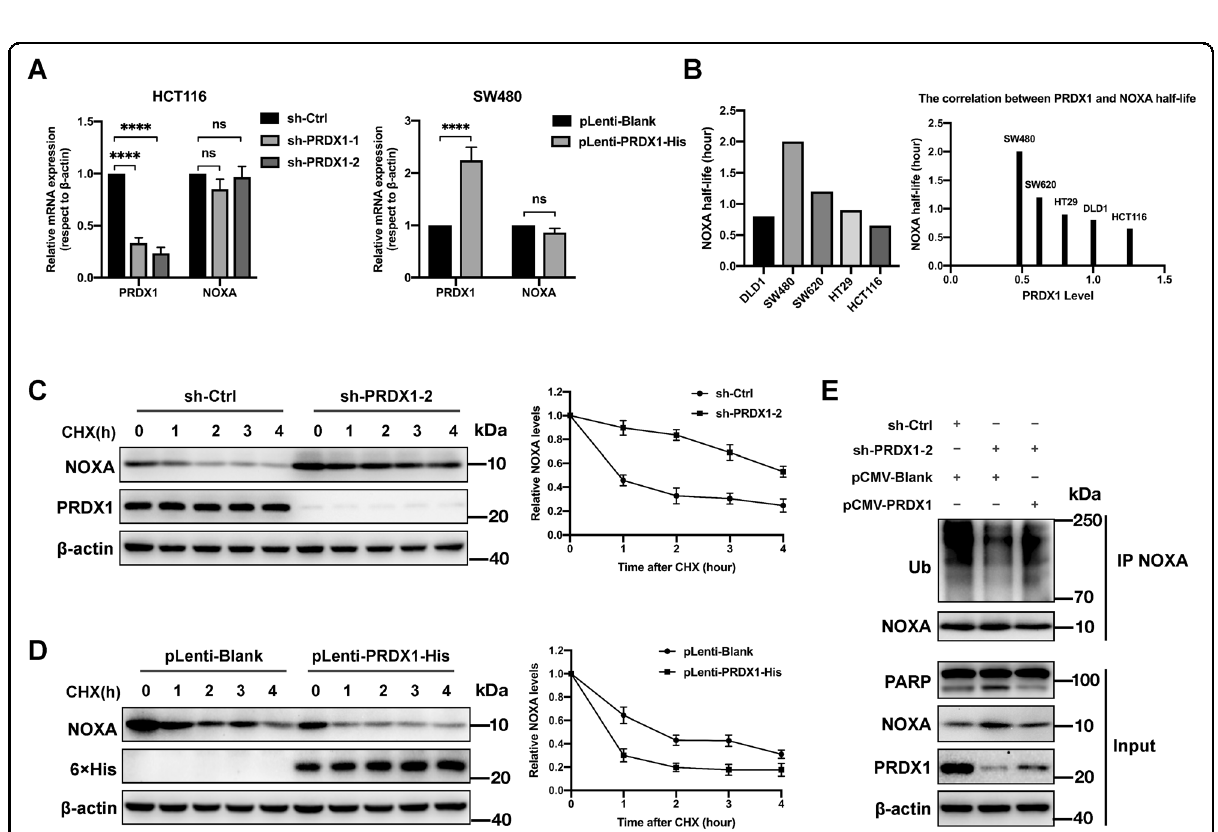
Fig. 3 PRDX1 promotes UPS-mediated degradation of NOXA in CRC cells. A mRNA levels of PRDX1 and NOXA with respect to those of β -actin in CRC cells after PRDX1 inhibition in HCT116 cells or PRDX1 overexpression in SW480 cells ( n = 12, mean ± SD; **** p < 0.0001). Cells transduced with the indicated shRNAs or plasmids were subjected to qPCR analysis. B Comparison of the NOXA half-life (based on Fig. 1F) and PRDX1 protein level (based on Fig. 2A) in the 5 CRC cell lines. C , D Measurement of the NOXA degradation rate in fl uenced by PRDX1: HCT116 ( C ) cells were transfected with shRNA to knock down PRDX1, while SW480 ( D ) cells were infected with recombinant lentivirus loaded with pLenti-PRDX1-His (pLenti-Blank as the control) and screened in BSD for 120 h. The obtained cells were switched to fresh medium (10% FBS) containing CHX (20 μ g/mL) and incubated for the indicated time periods before being harvested for WB analysis. E HCT116 cells infected with lentivirus expressing the indicated shRNAs, were complemented with the indicated plasmids (pCMV-blank, pCMV-PRDX1) and treated with 10 μ M MG132 for 10 h before co-IP and WB